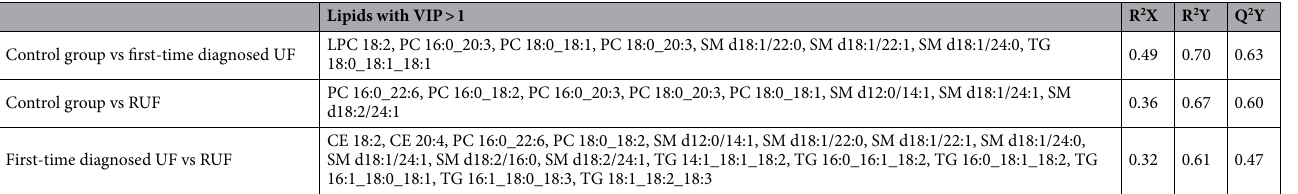
Table 2. The parameters of OPLS-DA models. CE cholesterol esters, LPC lysophosphatidylcholines, PC phosphatidylcholines, SM sphingomyelins, TG triglycerides.